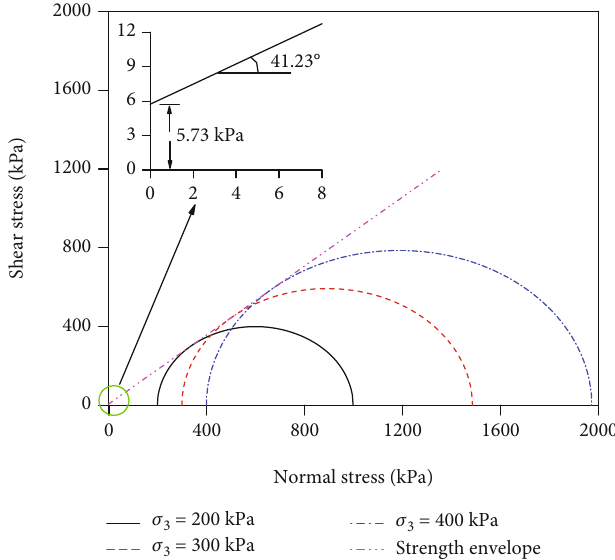
Figure 4: Mohr ’ s circle under preliminary mesoparameters.